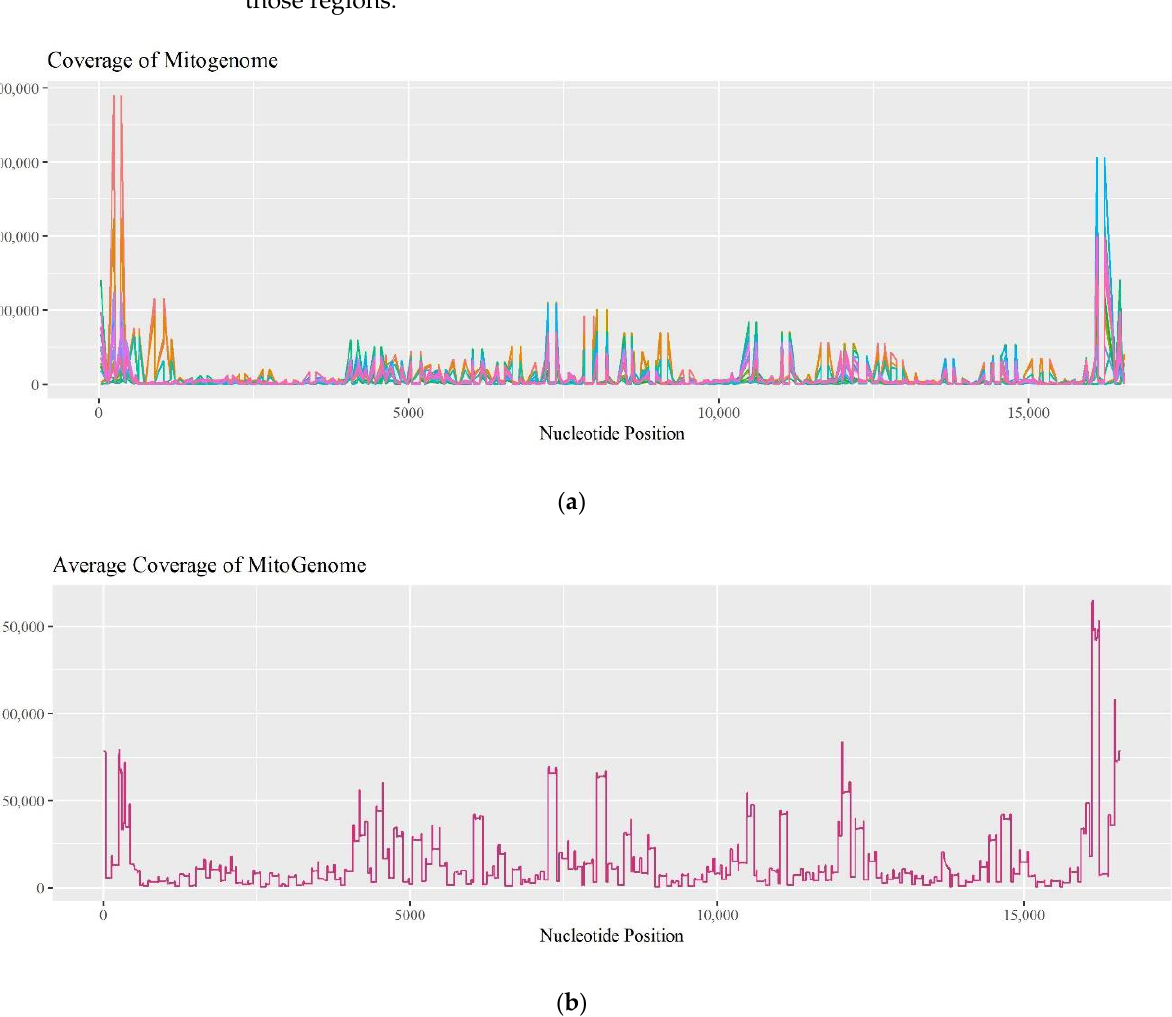
Figure 9. ( a ) A linear plot of the read depth across the mitogenome for the 15 samples that experienced amplicons dropping below 200 reads. ( b ) A linear plot of the average read depth for all 74 recent and old samples across the mitogenome.